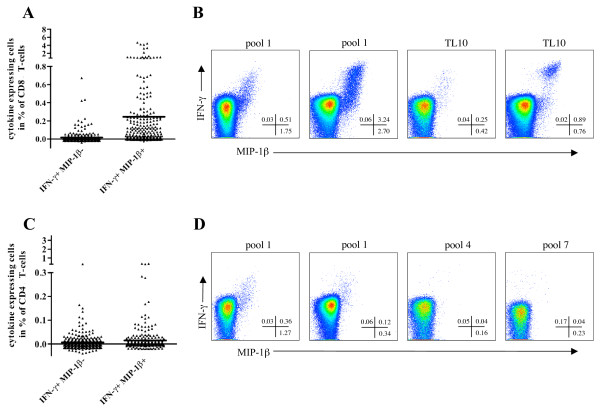
IFN-γ and MIP1-β expression in CD8 and CD4 T-cells stimulated with HIV-1-derived antigens. Percentages of IFN-γ+ MIP-1β- and IFN-γ+ MIP-1β+ CD8 (A) or CD4 (C) T-cells are shown for a total of 275 samples. The mean is depicted for each T-cell population. Representative pseudo-colour dot plots of data gated on living CD8+ CD3+ lymphocytes (B) or living CD4+ CD3+ lymphocytes (D) from 4 different patients are shown. In each plot the percentage of IFN-γ+ MIP-1β-, IFN-γ+ MIP-1β+ and IFN-γ- MIP-1β+ is indicated in the bottom-right corner. The pools used for PBMC stimulation are described in Table 1. TL10, TPGPGVRYPL.